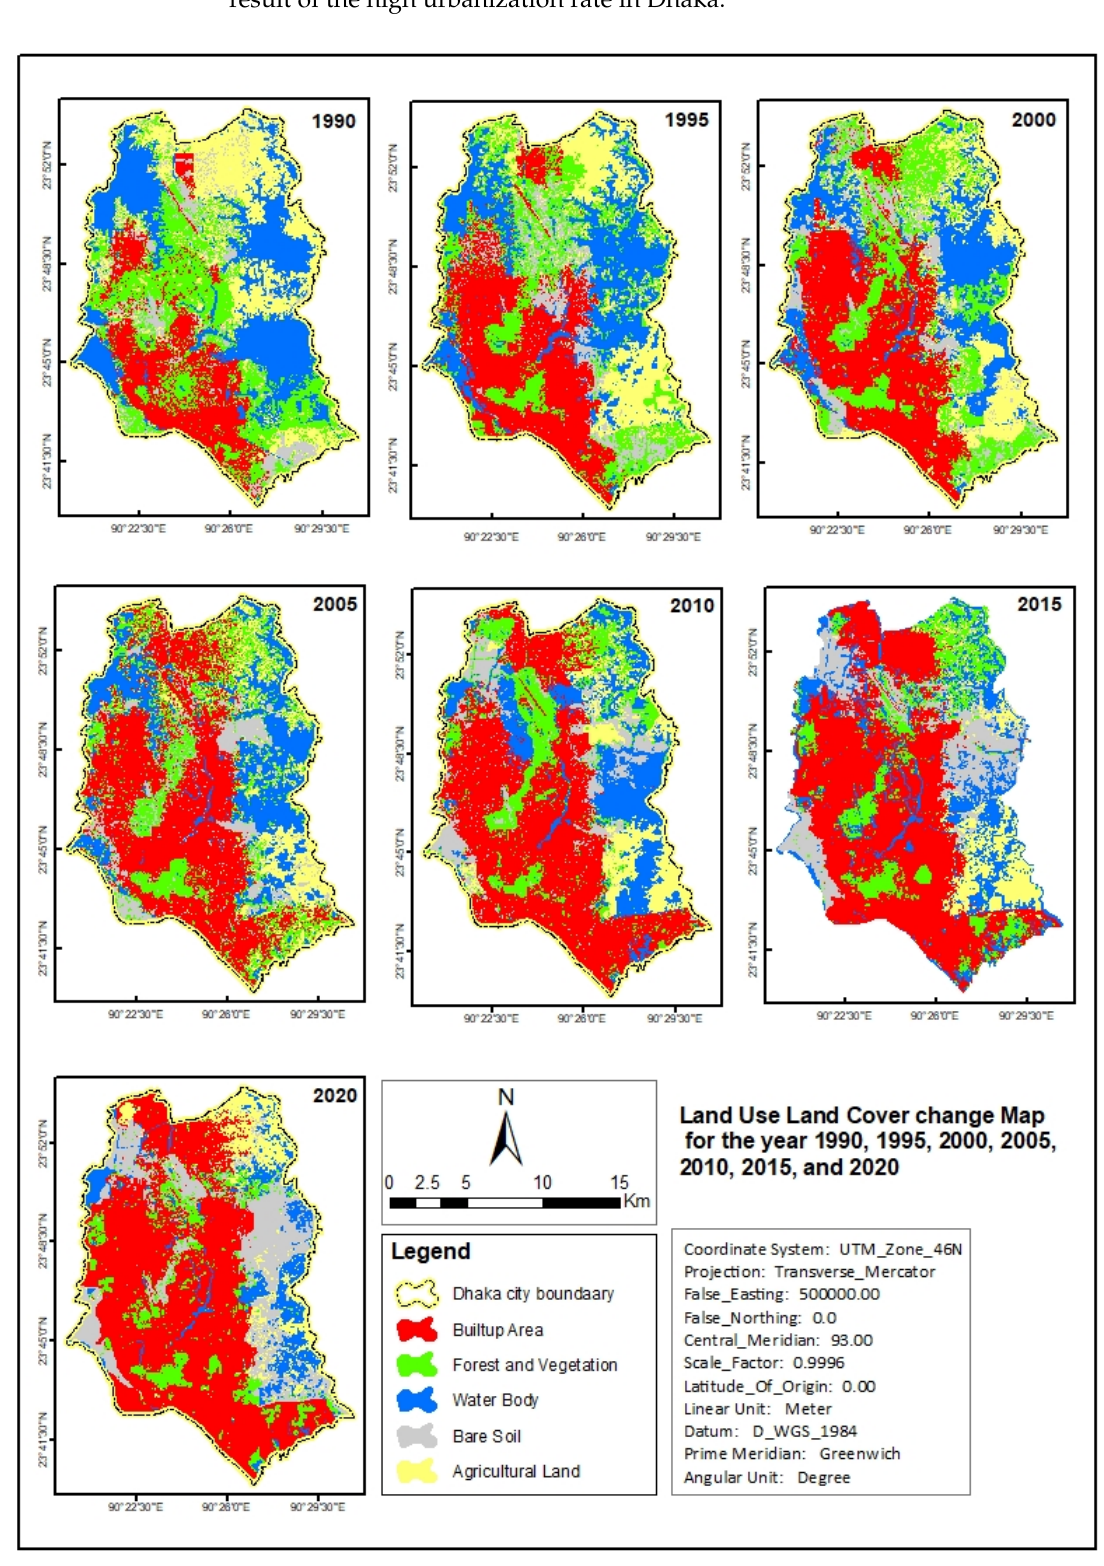
Figure 2. Land use and land cover change map of Dhaka for the years 1990, 1995, 2000, 2005, 2010, 2015, and 2020.